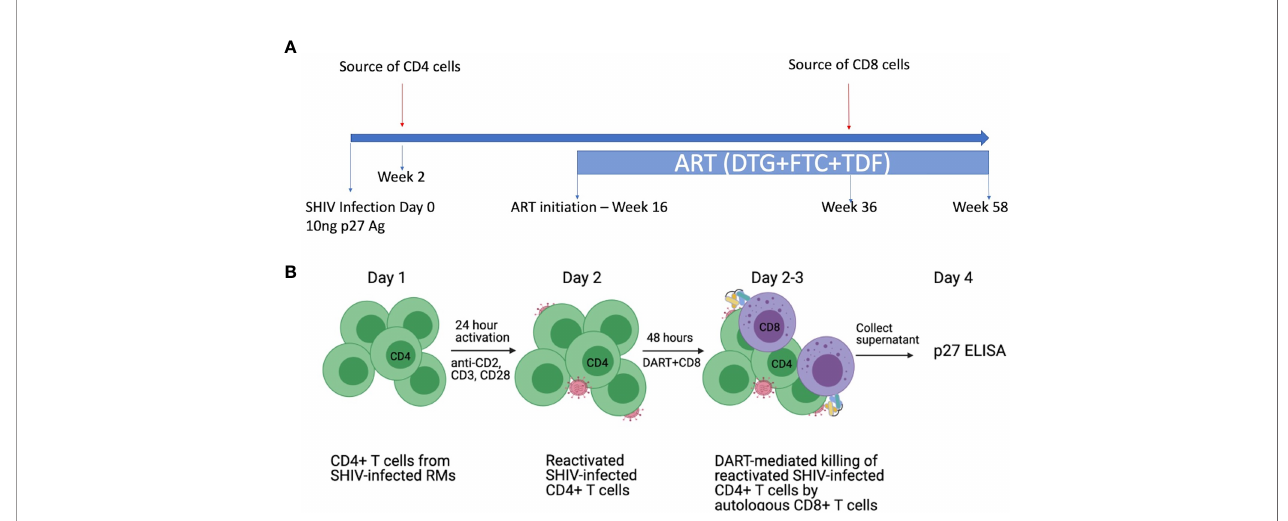
FIGURE 2 | Ex vivo killing assays with SHIV-infected RM CD4+ T cells and autologous RM CD8+ T cells. (A) Schematic of the in vivo study. Rhesus macaques (RMs) were infected intravenously (i.v.) with SHIV.CH505.375H at a dose of 10 ng of SIV Gag p27 antigen (41). SHIV.CH505.375H is a chimeric simian/human immunode fi ciency virus with SIVmac backbone and HIV-1 transmitted/founder clade C envelope CH505. The RMs were treated with an ART regimen consisting of tenofovir (TDF: 5.1 mg/kg), emtricitabine (FTC: 40 mg/kg), and dolutegravir (DTG: 2.5 mg/kg) administered subcutaneously daily from week 16 post-infection (p.i.) to the end of the study. PBMCs were collected from the SHIV-infected RMs at week 2 post-infection (prior to ART) to isolate SHIV-infected CD4+ T cells (targets) and at week 36 post-infection (while on ART) to isolate CD8+ T cells (effectors). (B) Design of the ex vivo killing assays. Primary CD4+ T cells from SHIV.CH505.375H- infected RMs were isolated and activated in vitro for 24 hours with antibodies speci fi c for nonhuman primate CD2/CD3/CD28. Activated SHIV-infected RM CD4+ T cells were cultured for 48 hours alone or with autologous RM CD8+ T cells at an E:T ratio of 0.03:1 in the absence or presence of DART molecules. The % killing of the SHIV-infected RM CD4+ T cells was determined by measuring the reduction in supernatant SIV Gag p27 levels compared to CD4+ T cells